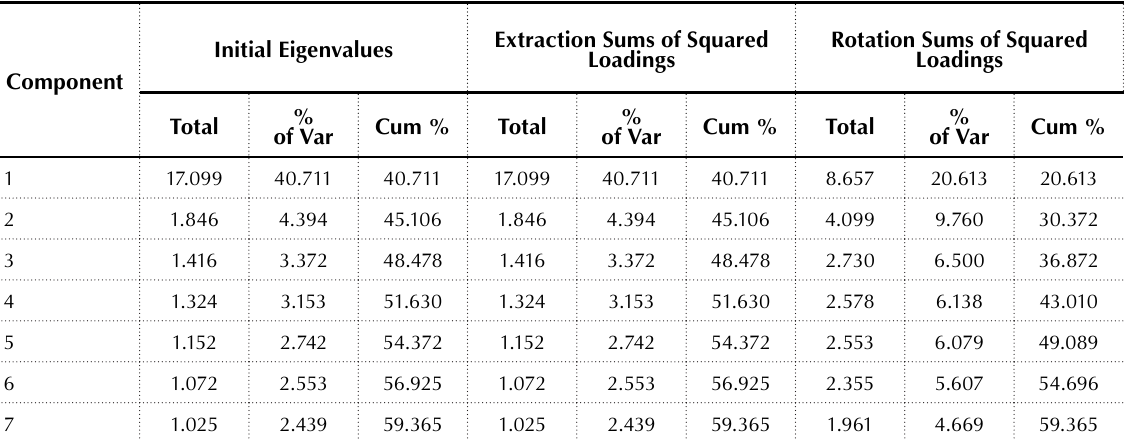
Table 5. Total variance explained by factors